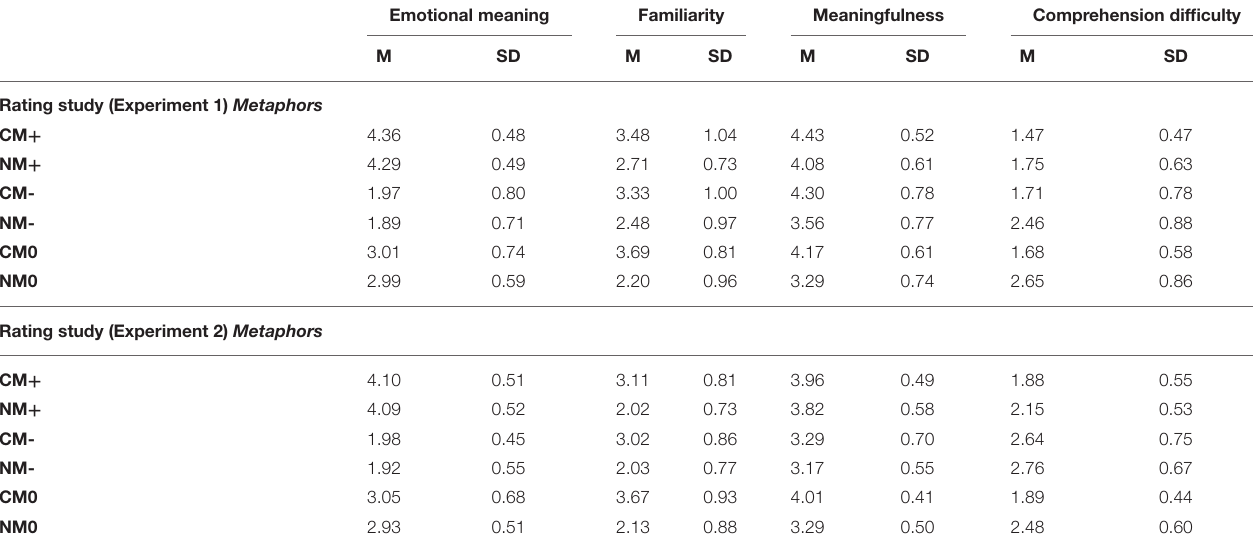
TABLE A1 | Mean (M) and standard deviation (SD) for each measure of the metaphors in Experiment 1 and Experiment 2. Emotional meaning Familiarity Meaningfulness Comprehension difficulty M SD